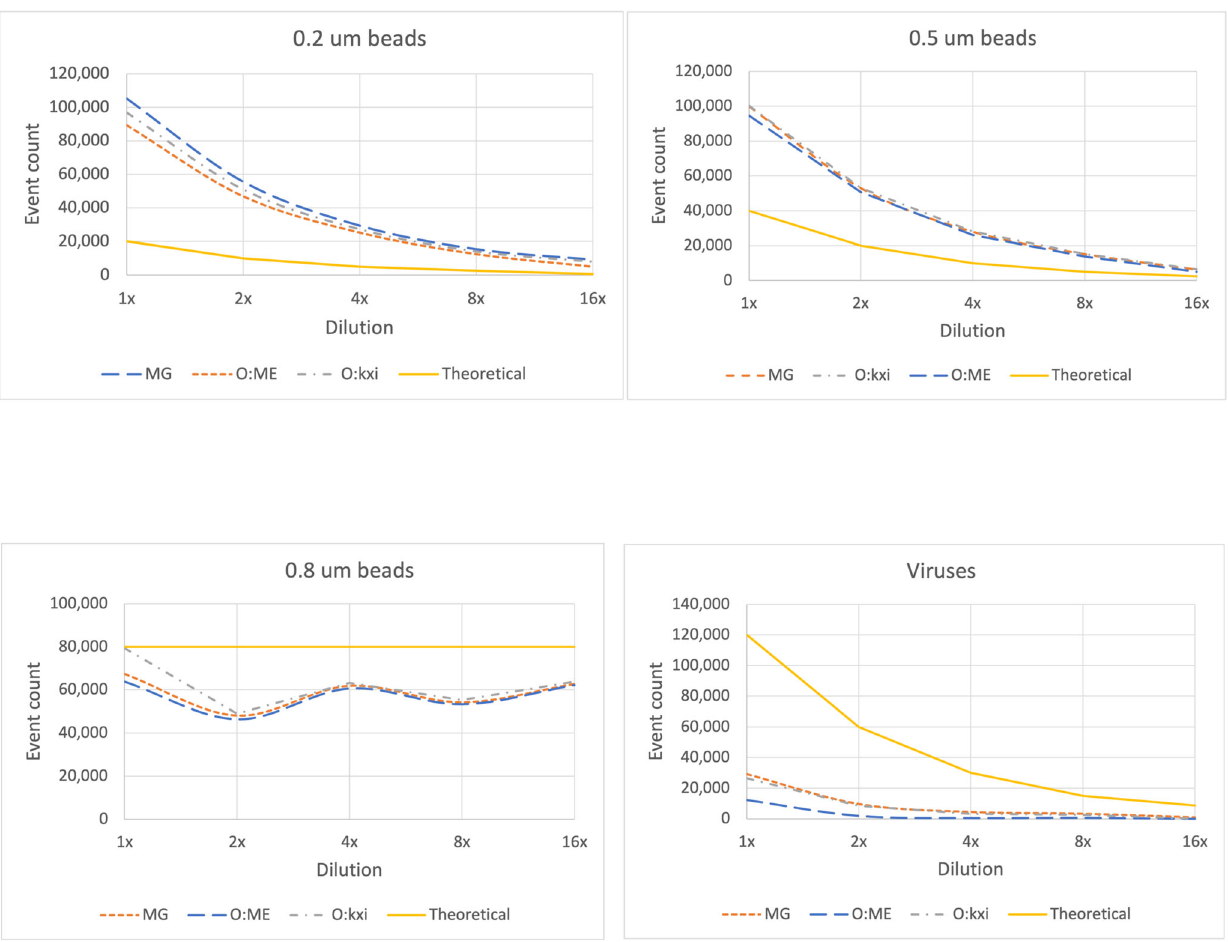
Fig. 6 Event counts vs. dilution for the mixed-target data experiments, by clustering approach and target “ bucket ” . MG manual gating, O:ME OPTICS:Manual extraction, O:kxi OPTICS:kxi extraction. The “ Viruses ” plot refers to the virus “ bucket ” described in the text.